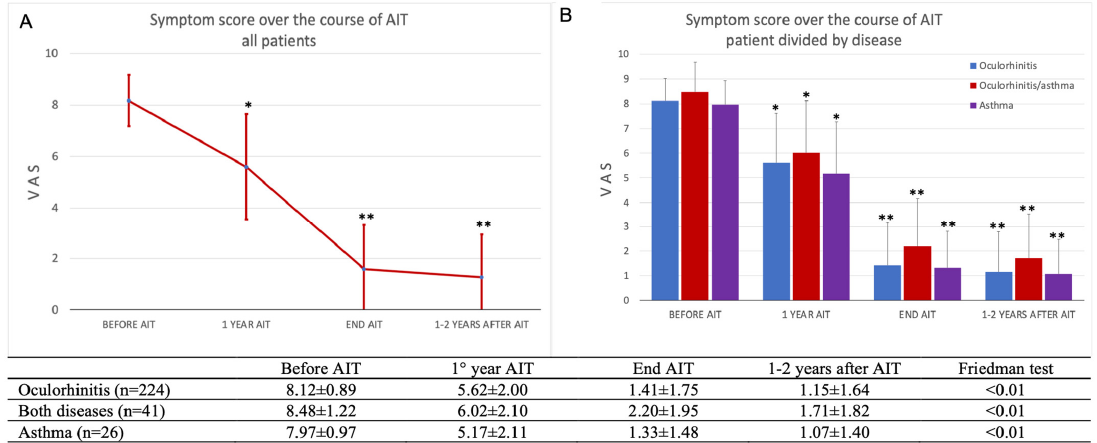
Figure 1. Symptom score evaluated by VAS over the years of AIT. A significant decrease of VAS was observed in all patients (291) ( A ), and selecting patients with oculorhinitis, asthma, or both ( B ). Values are expressed as (μ ± SD). * p < 0.01 Wilcoxon test comparing VAS changes at 1 year AIT respect before. ** p < 0.01 Friedman test detecting differences across the course of AIT. Table 2. VAS changes in AIT-treated patients divided by allergic sensitization.